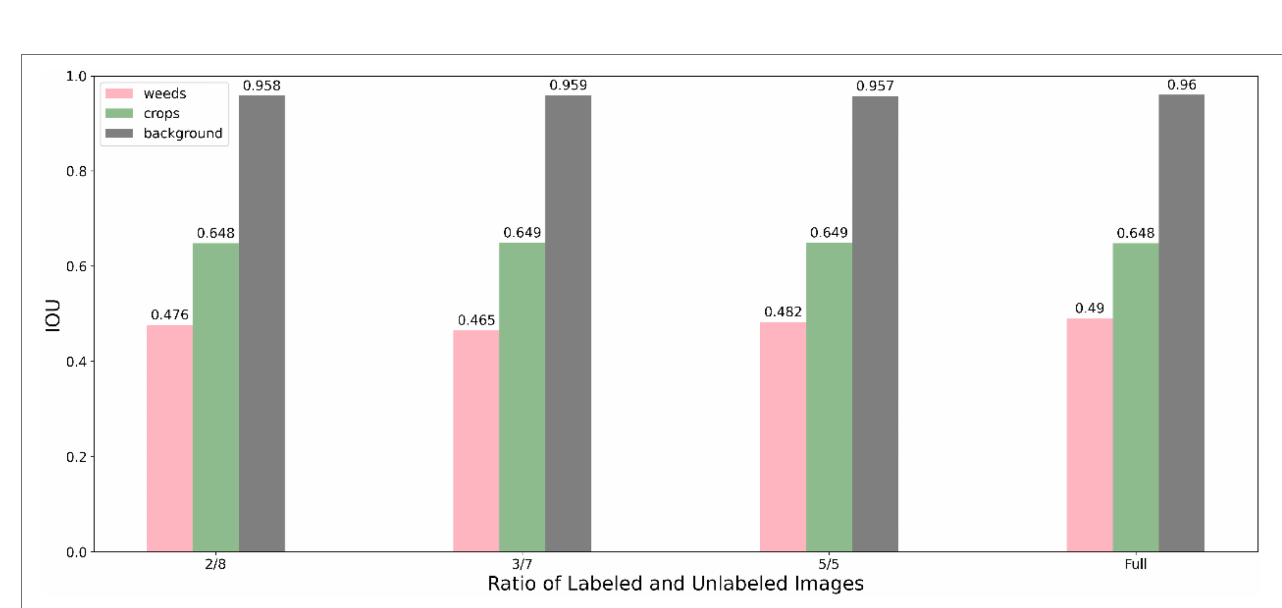
FIGURE 5 | Performance of the proposed method using Resnet 50 under different labelled data